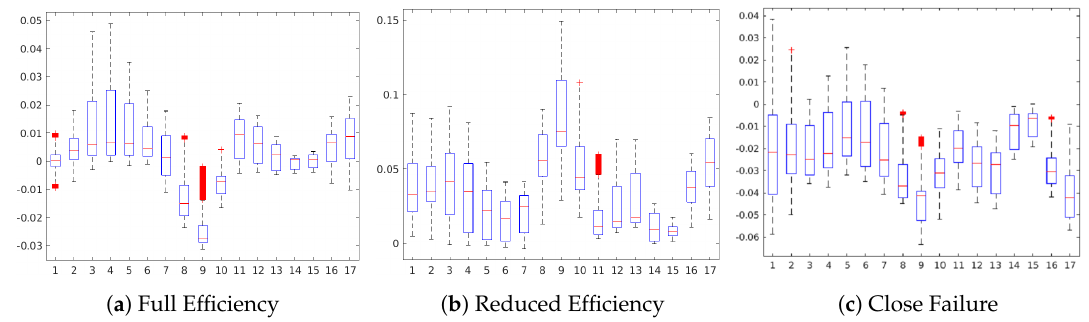
Figure 8. Boxplot of the sensor contributions for the Cooler